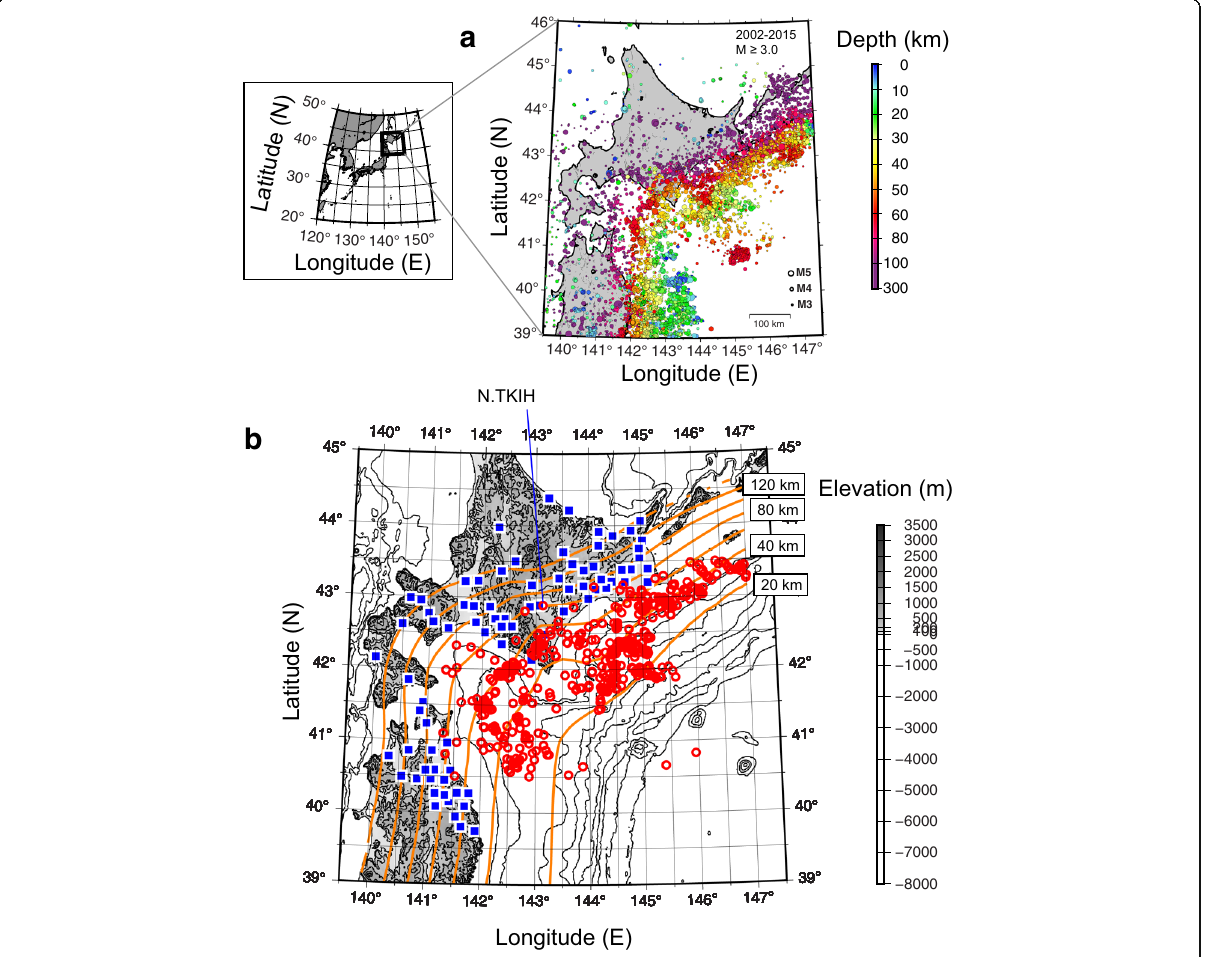
Fig. 1 a Seismicity in the study region from 2002 to 2015. Hypocenters with M greater than or equal to 3.0, as determined by JMA, are plotted. The color and size of the symbols indicate the depth and magnitude of earthquakes, respectively. We can clearly see that most earthquakes occur on the subduction interface of the Pacific Plate. b Hypocenters of analyzed earthquakes and seismic stations used in this study. The red circles indicate hypocenters, and the blue squares indicate seismic stations, including stations of Hi-net (NIED), JMA, and Hokkaido University. The orange lines indicate the depth of the upper surface of the subducting Pacific Plate (Kita et al. 2010) at intervals of 20 km. Waveforms observed at the station N.TKIH are shown in Figs. 2 and 3 as